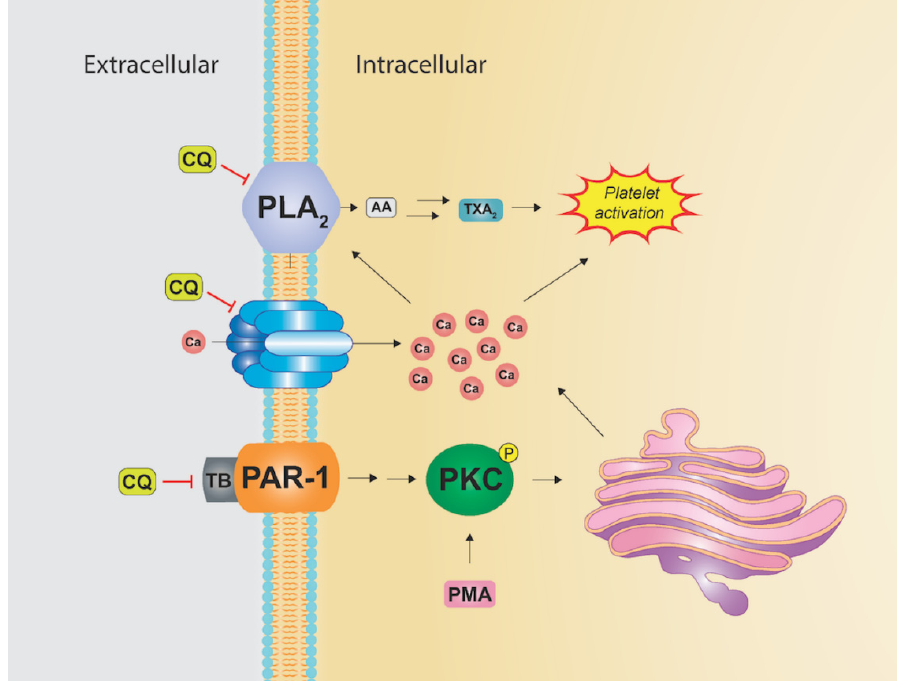
Figure 6. The influence of CQ on intracellular calcium concentration. CQ inhibits increases in intracellular calcium via calcium ionophores, thrombin (TB), and phorbol-myristate-acetate (PMA). Elevated intracellular calcium can stimulate release of phospholipase A2 (PLA2), leading to arachidonic acid (AA) liberation and subsequent platelet activation.